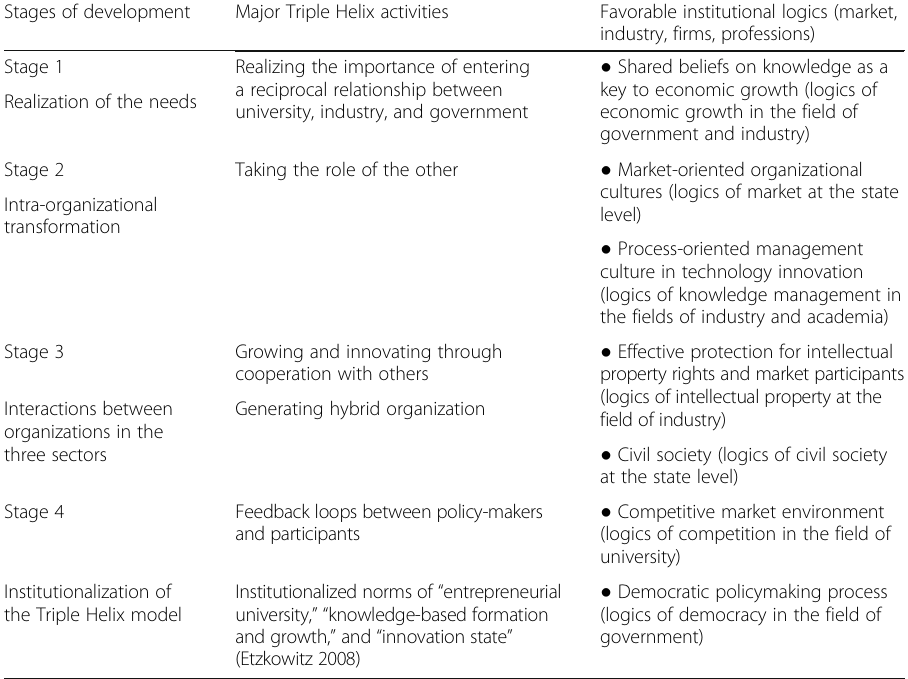
Table 1 Institutional orders in the Triple Helix model Stages of